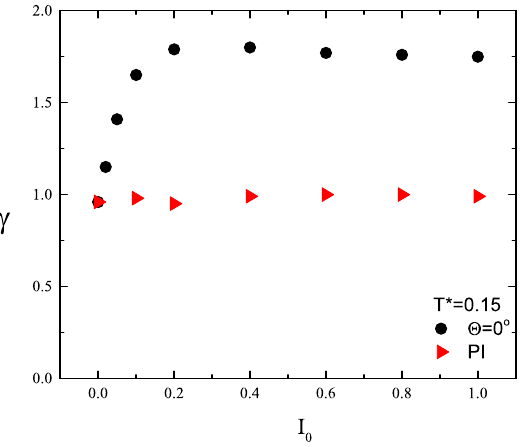
Figure 8. Plot of exponent γ ( I 0 ) for FPM with linearly polarized light (black circles, Θ = 0 ◦ ) and for PI model (red triangles). Experimental errors are of the size of graphical symbols.